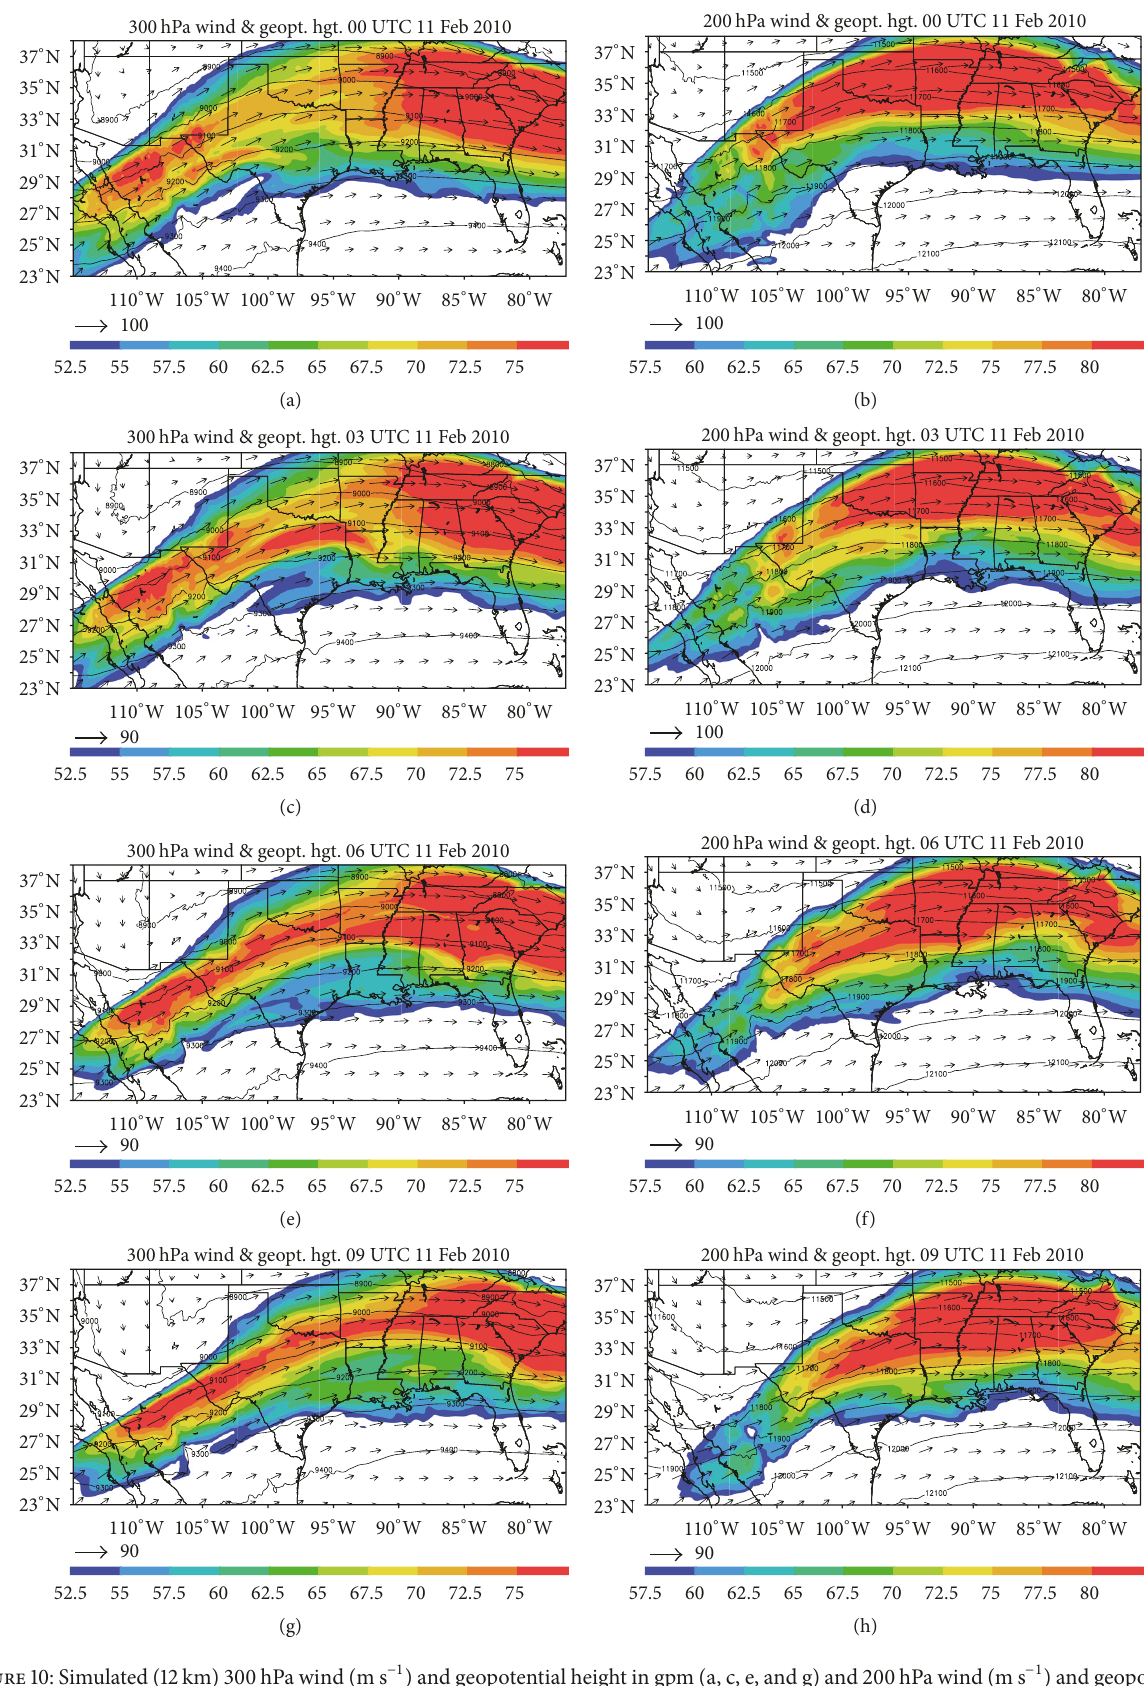
Figure 10: Simulated (12km) 300 hPa wind (m s −1 ) and geopotential height in gpm (a, c, e, and g) and 200 hPa wind (m s −1 ) and geopotential height in gpm (b, d, f, and h) on 0000, 0300, 0600, and 0900 UTC 11 February